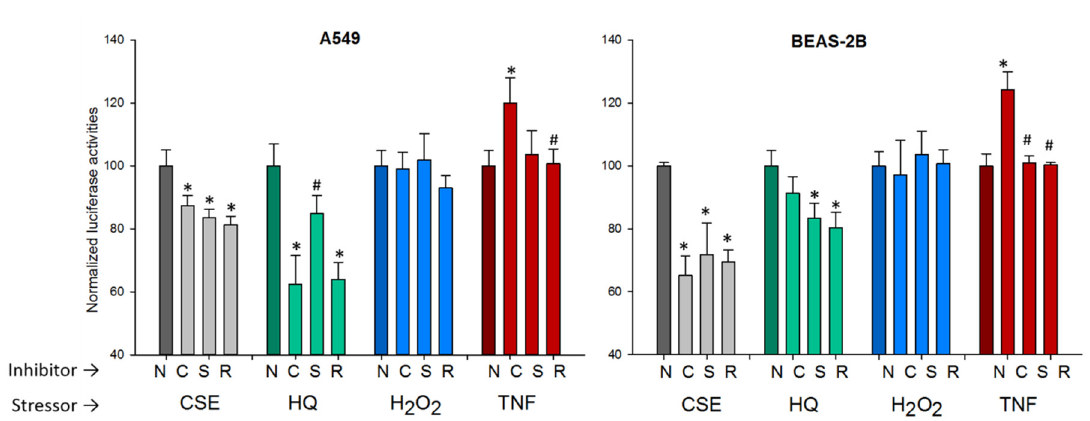
Figure 9. Effects of CMC (C), (4 S )-CMCO (S), and (4 R )-CMCO (R) on activation of NF- κ B pathway by stressors in A549 and BEAS-2B cells. The luciferase activities in the treated cells are normalized for the reporter activity in wells receiving no inhibitor (N). The stressor concentrations are indicated in Figure 6. The inhibitor concentrations were 1 mM in all experiments. The error bars are SDs; n = 3. The differences of means were probed by the one-way ANOVA; * indicates a statistically significant difference between an inhibitor treatment and “no inhibitor” control; # indicates a statistically significant difference between CMC and CMCO treatments, p < 0.05.